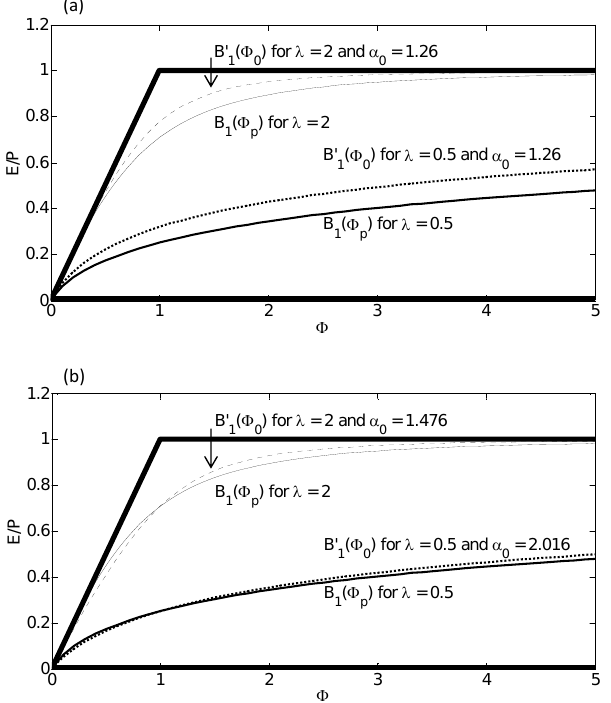
Figure 3. Comparison between the Turc–Mezentsev function B 1 ((cid:56) p ) (Eq. 4) in solid line and its corresponding function B 1 (cid:48) ((cid:56) 0 ) (Eq. 20) in dotted line for two values of λ (0.5 and 2) and b = 1: (a) with α 0 = α w = 1 . 26; (b) with α 0 adjusted according to Eq. (22) for (cid:56) = 1. The x axis legend (cid:56) represents either (cid:56) p for B 1 ((cid:56) p ) or (cid:56) 0 for B 1 (cid:48) ((cid:56) 0 ) .